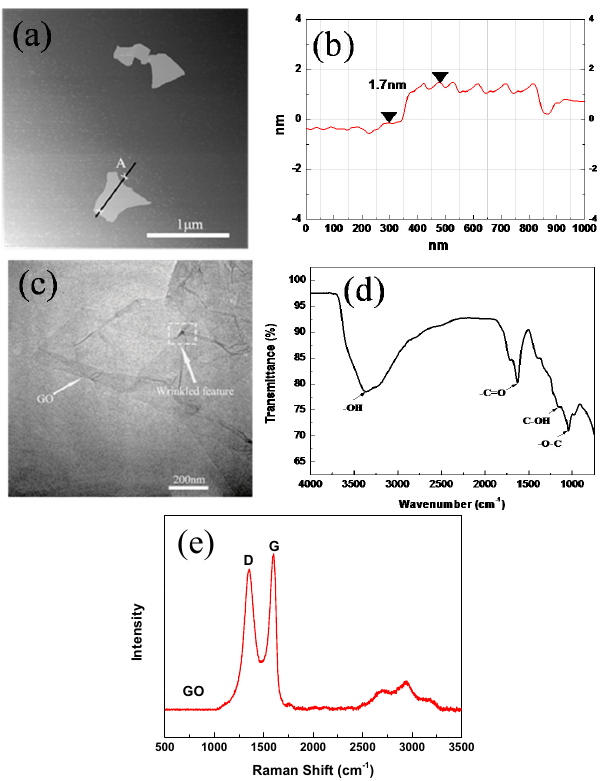
Figure 5. The characterization of graphene oxide (GO). ( a , b ) atomic force microscope (AFM) spectra of GO; ( c ) Image transmission electron microscopy (TEM) of GO; ( d ) Fourier transform infrared spectrometer (FTIR) transmittance spectra of GO; and, ( e ) Raman spectra of GO.